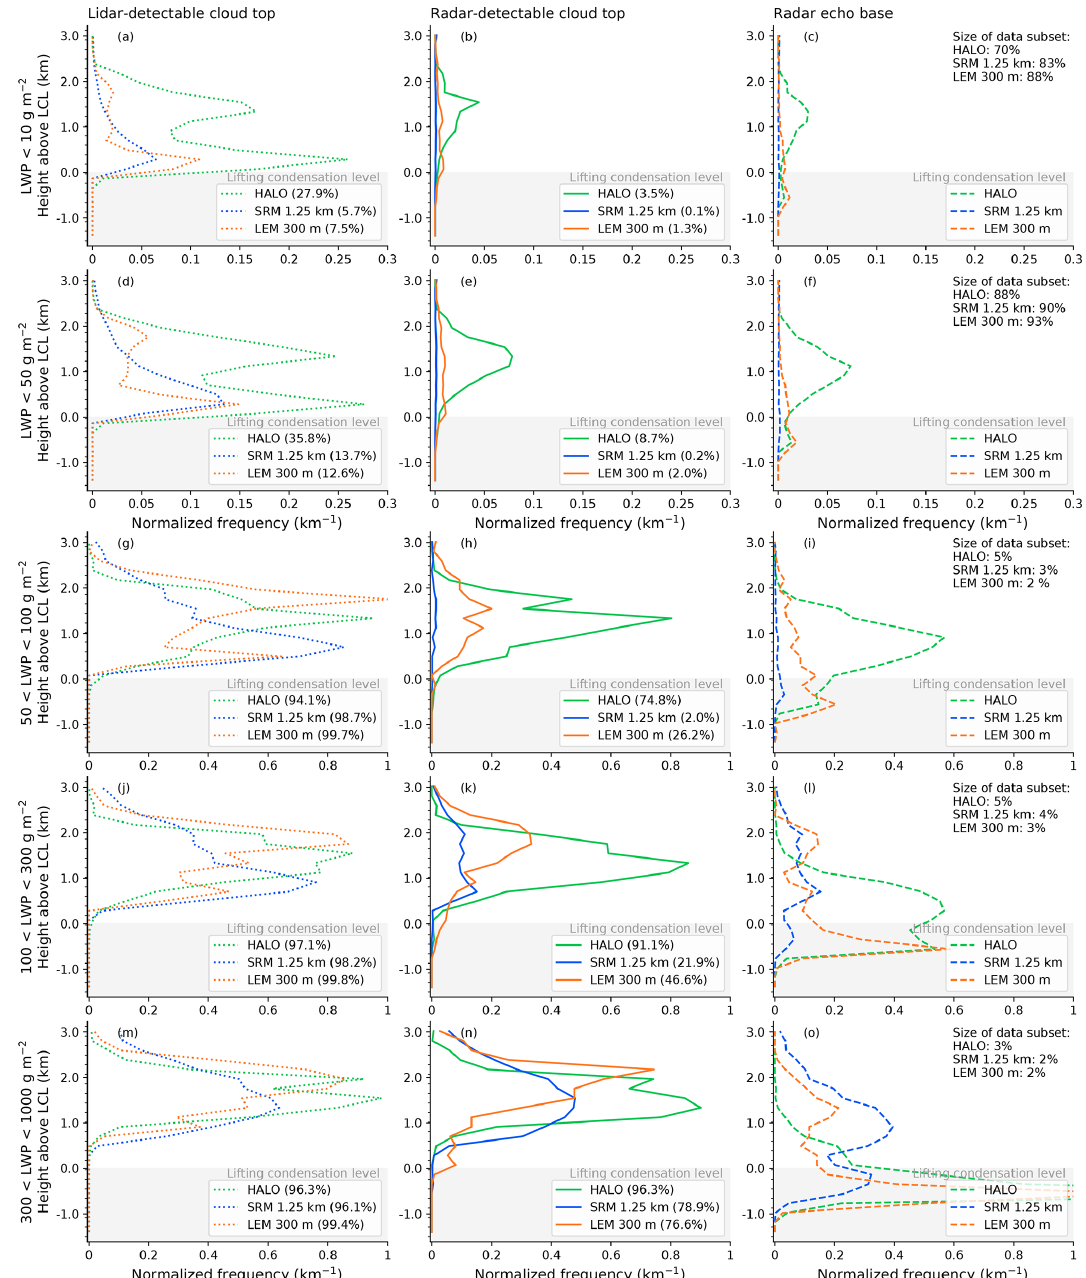
Figure 7. Similar to Fig. 5 but classified by liquid water path (LWP). Columns represent lidar cloud top, radar cloud top, and radar base of observed and forward-simulated lidar and radar signals. Rows represent different LWP ranges. Note the different x scale used in the upper two